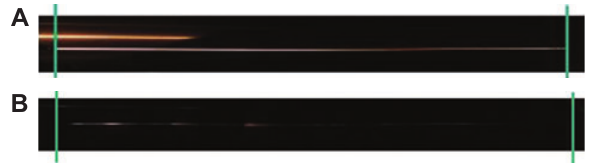
H /O detonation (equivalence 2 6 2